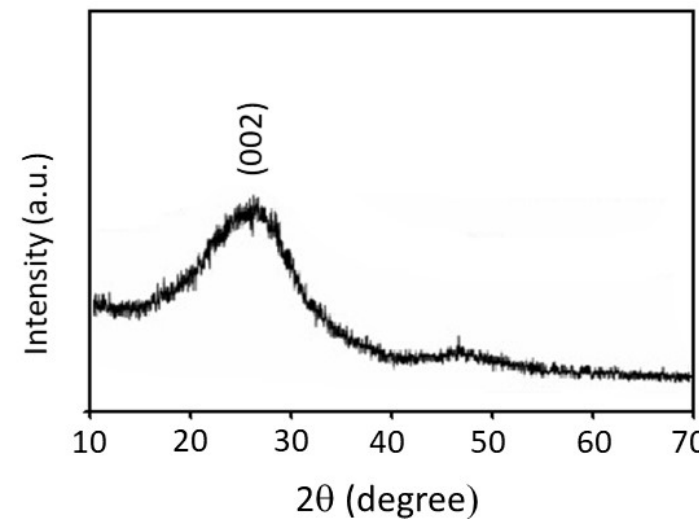
Figure 3. XRD pattern of the carbon-fiber membrane prepared after the carbonization of polyacrylonitrile (PAN) fibers at 700 °C.